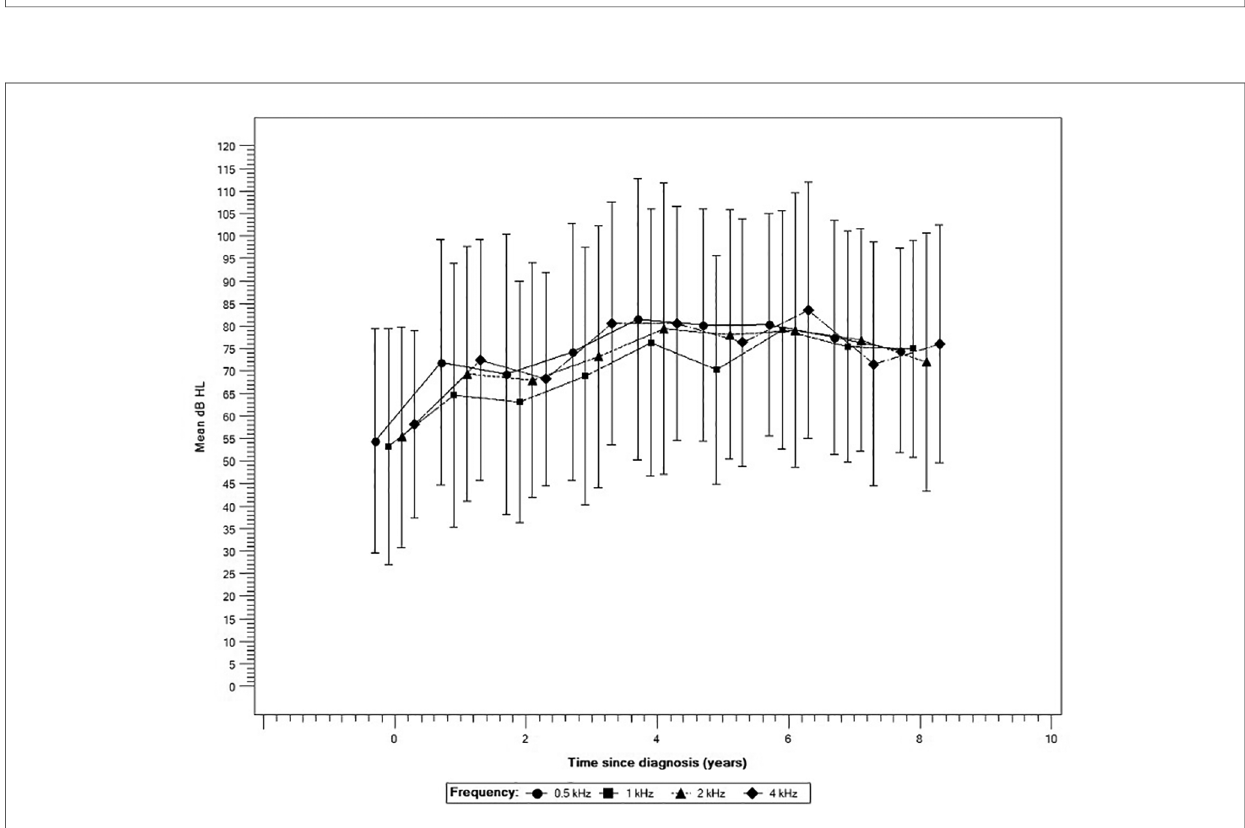
FIGURE 4 Trajectory of hearing loss across four frequencies ( n =77). Error bars represent one standard